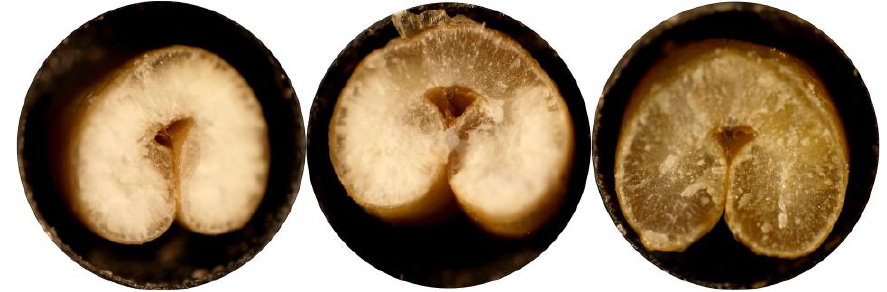
Figure 1. Clear cut of the wheat grain (mealy, partly vitreous and vitreous).